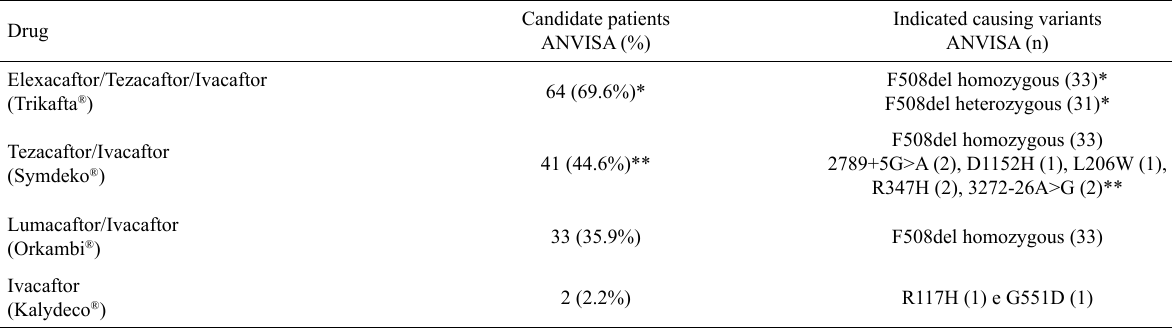
Candidate patients ANVISA